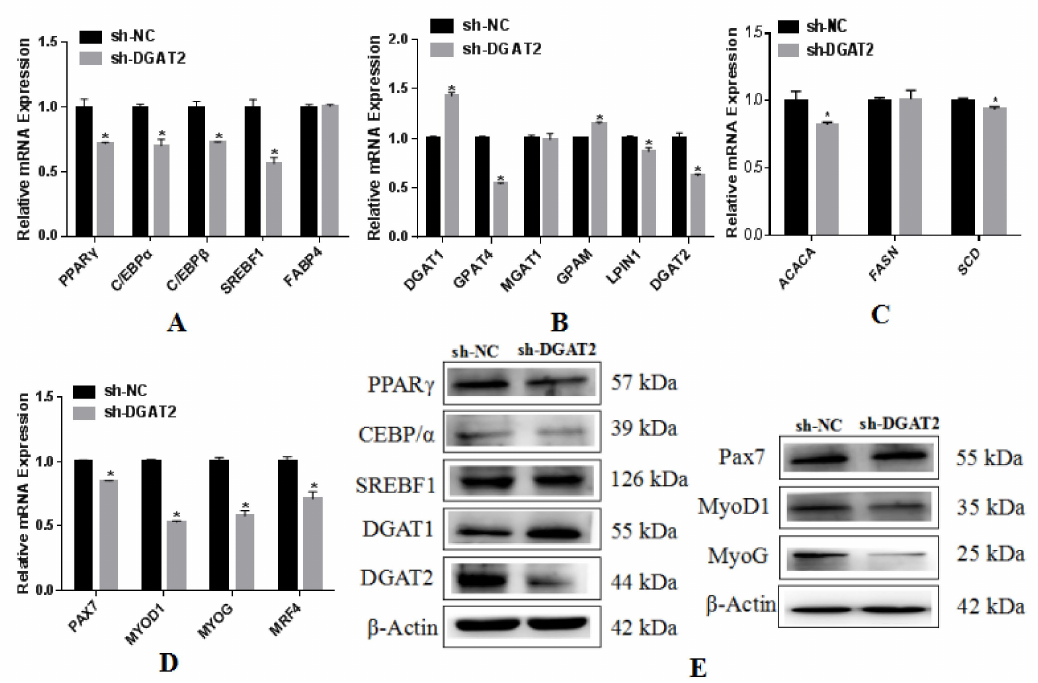
Figure 6. Interference with the expression of DGAT2 inhibits the expression of genes related to adipogenesis and lipid metabolism in BSCs. mRNA expression levels of genes associated with ( A ) lipogenesis, ( B ) triglyceride synthesis, and ( C ) fatty acid synthesis in BSCs. ( D ) Interference